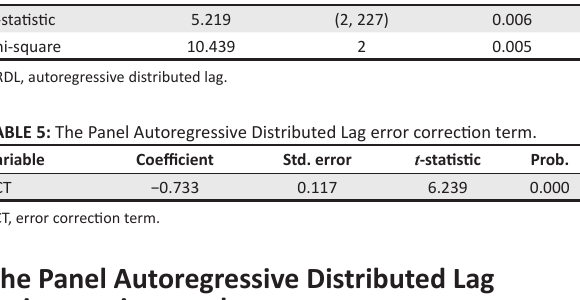
TABLE 4: The Panel Autoregressive Distributed Lag co-integration test (Wald test). Test